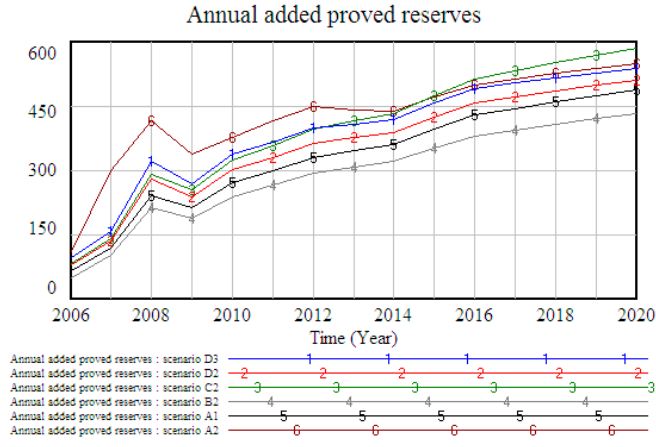
Figure 14. Annual added proved reserves (billion cubic meters).